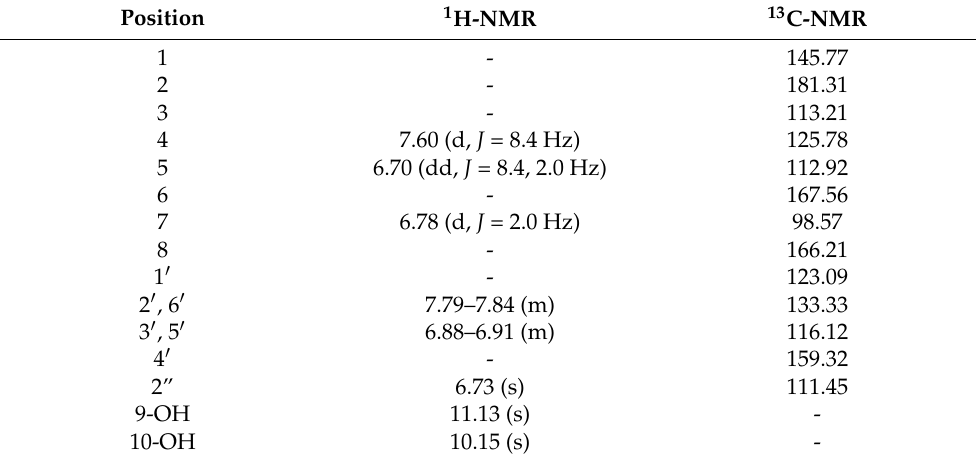
Figure 1. Active substance structure. ( A ) 1 H– 1 H COSY (H H, red) and HMBC (H C, blue) key correlations of the active compound. ( B ) Chemical structural formula. Table 3. 1H NMR (600 MHz) and 13C NMR (150 MHz) data of in d6-DMSO.